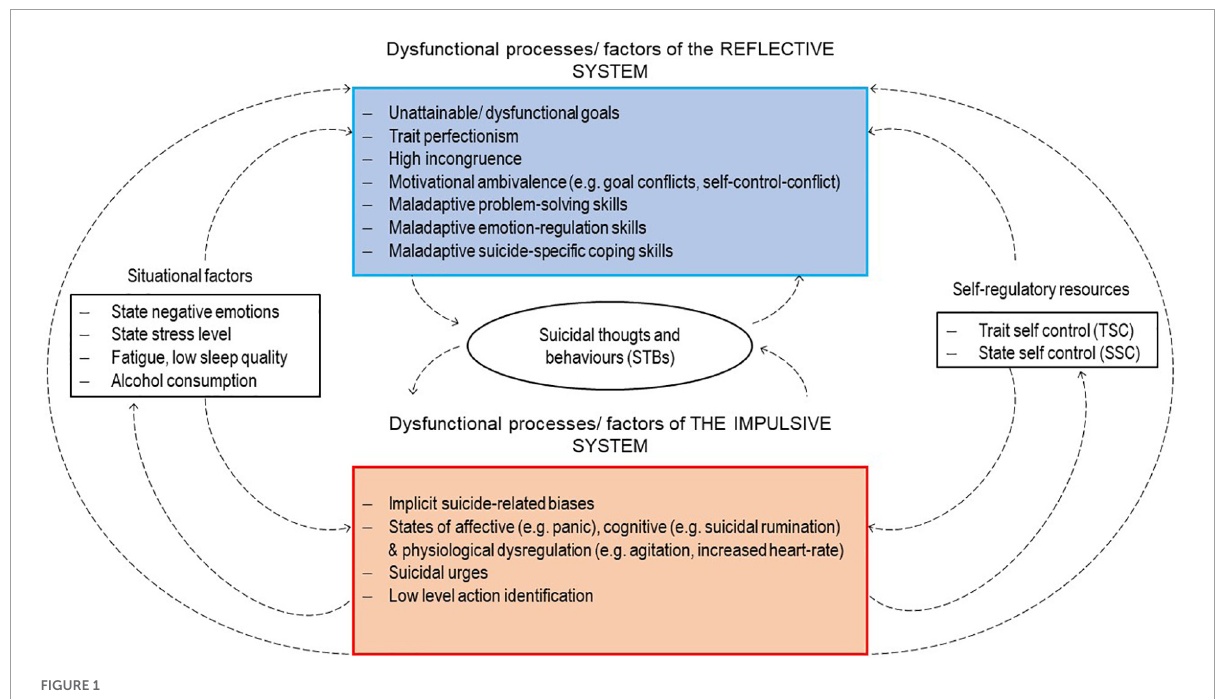
FIGURE1 The Dual-System Model of Suicidality